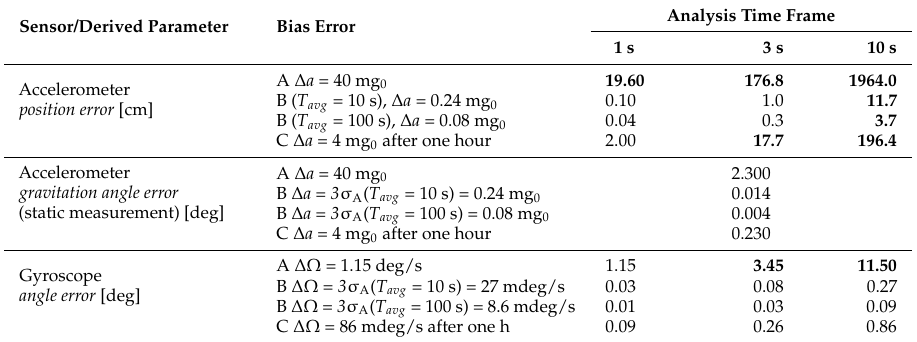
Table 2. Predicted analysis accuracy of accelerometer and gyroscope data in different bias compensation states and different analysis time frames. Red colored values indicate accuracies that are outside of the boundaries set for the example biofeedback application presented in the introduction